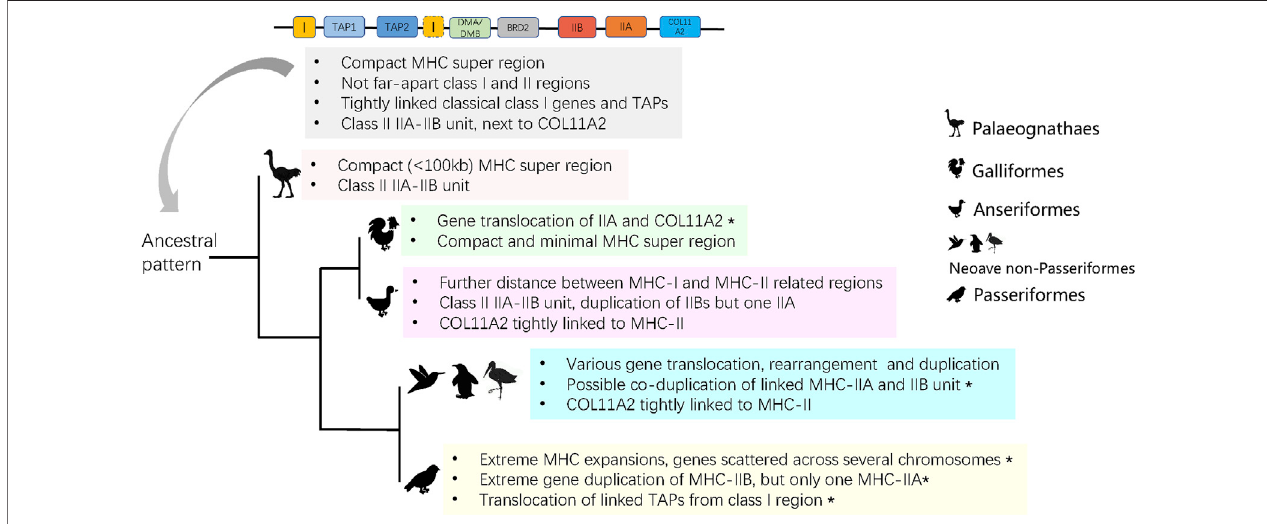
FIGURE 5 | The predicted ancient MHC architecture in birds and its evolution in derived groups. Asterisks indicate characters that are unique to a group.